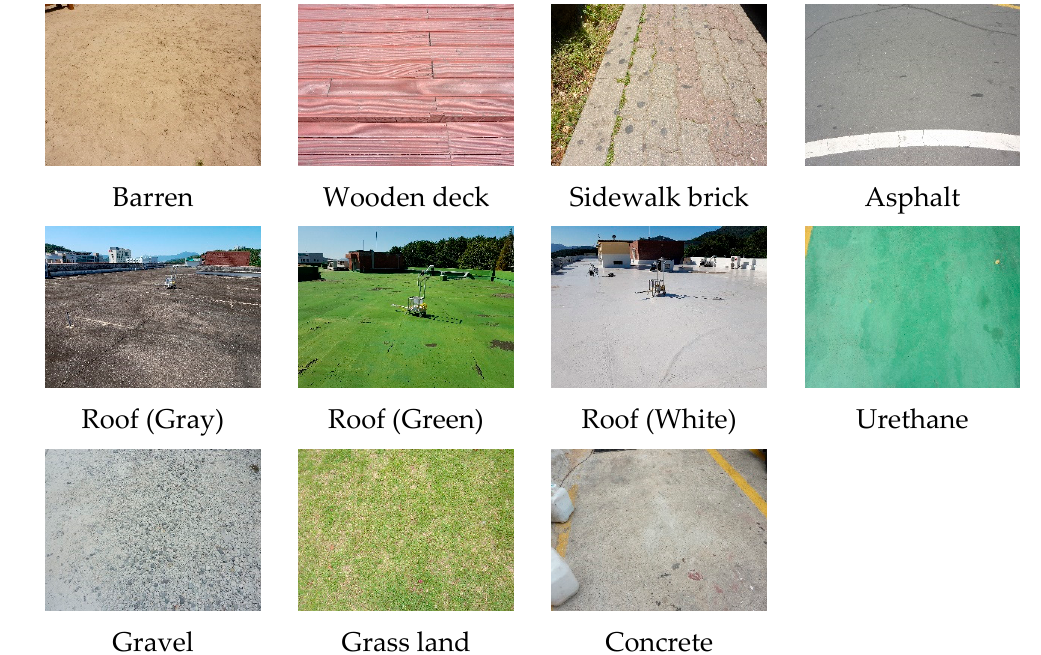
Figure 3. Actual images of land cover materials.